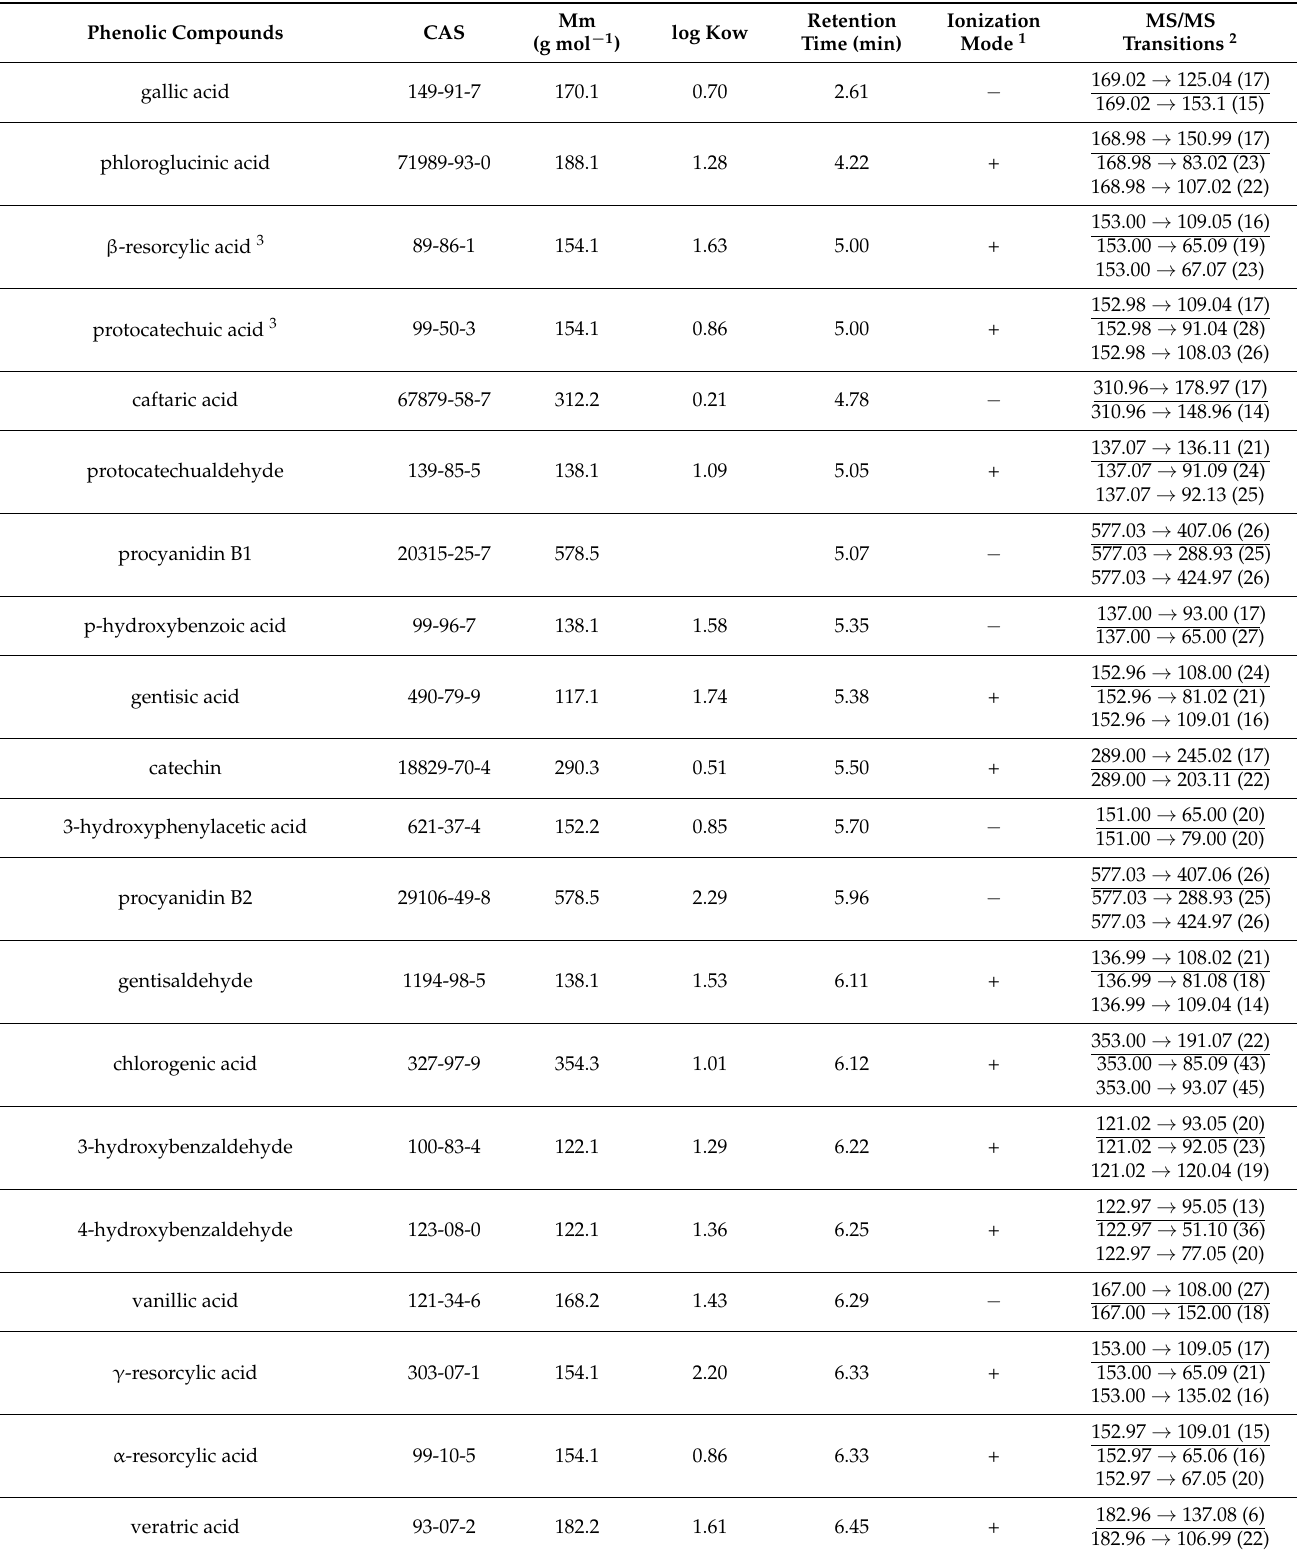
Table 1. Target phenolic compounds: CAS number, molecular mass (Mm), log Kow, retention time, ionization mode and MS/MS